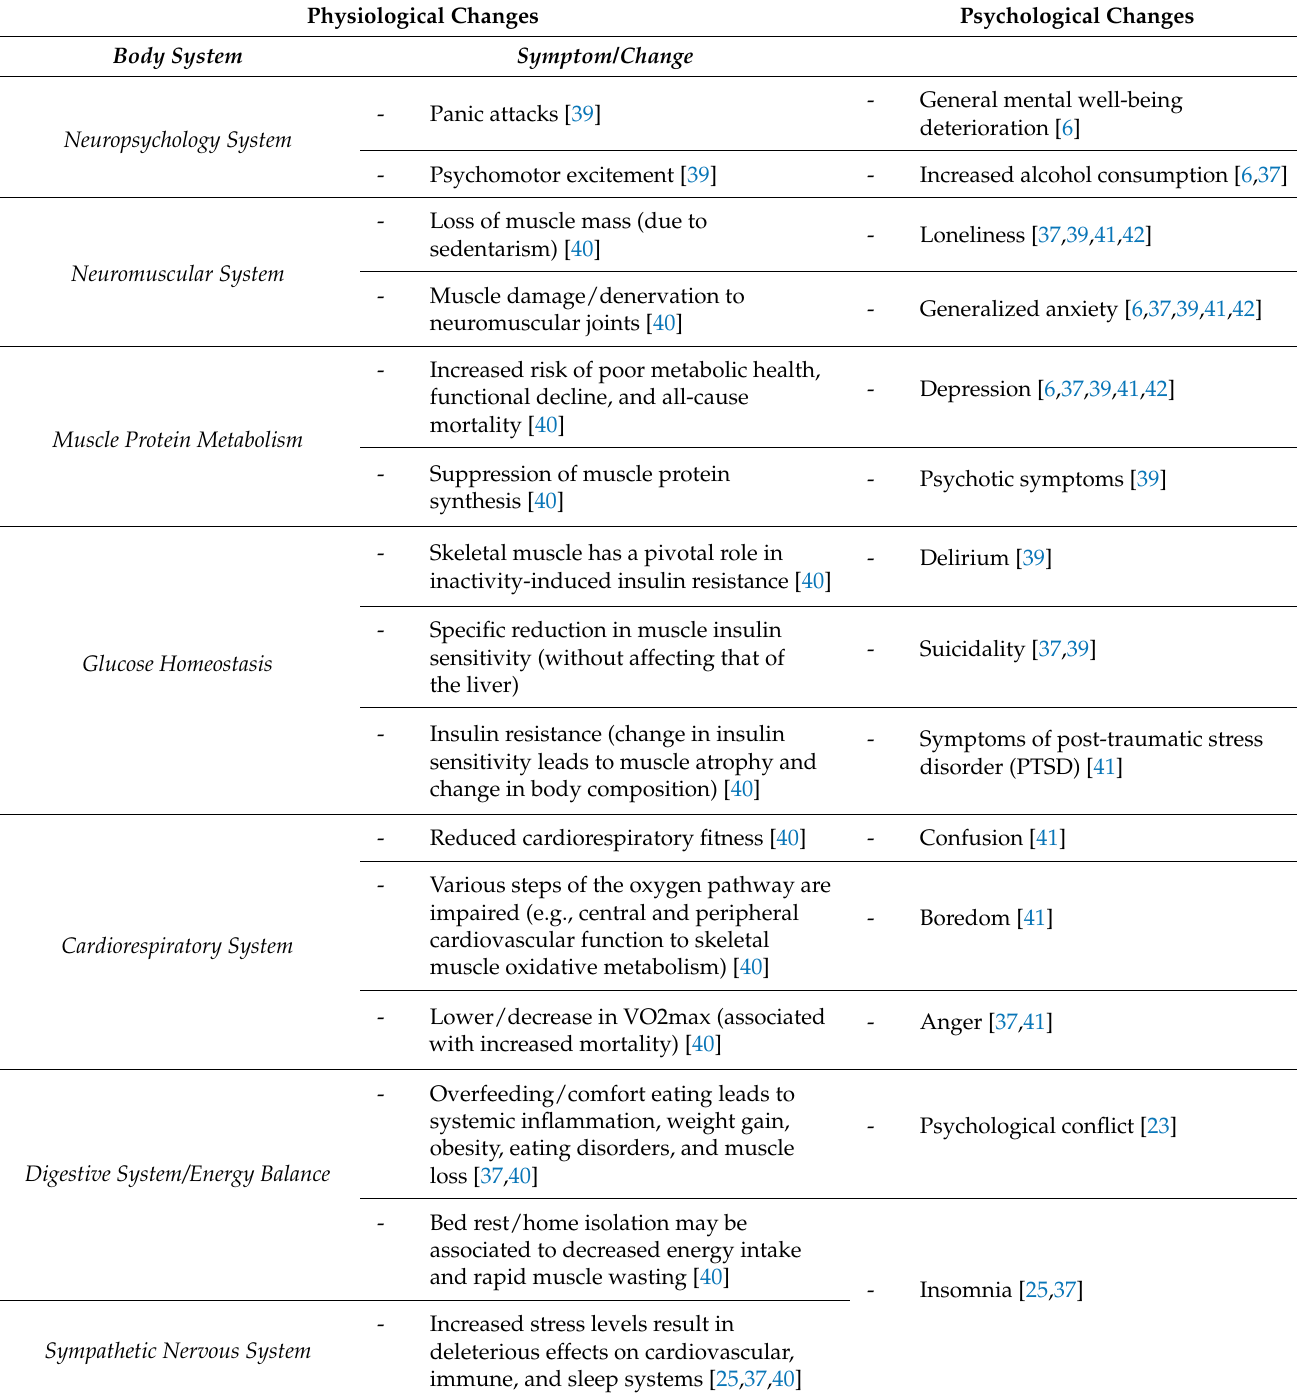
Table 2. Physiological and psychological health issues associated with social isolation. It is important to note that many of the factors mentioned are often comorbid and associated with one another and that these consequences are health risks for “secondary” conditions (e.g., alcohol consumption is a risk factor for depression